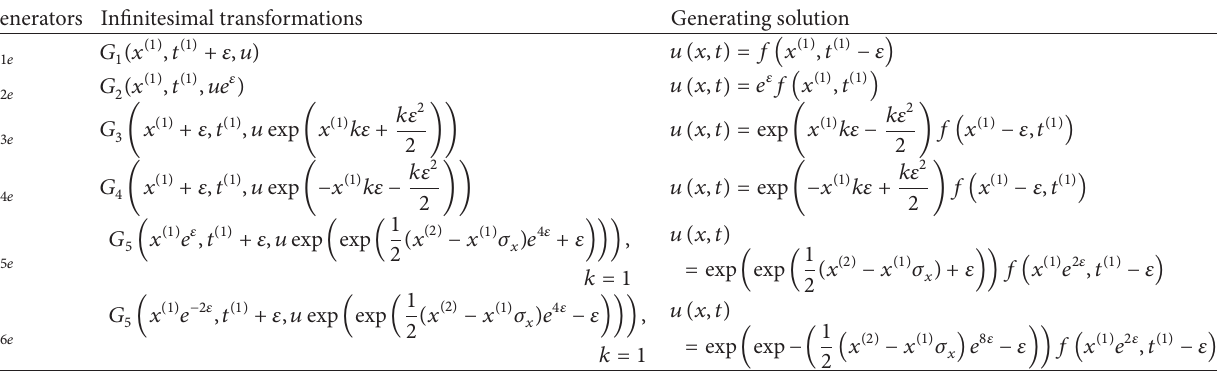
Table 5: Generating solutions for discrete harmonic oscillator.